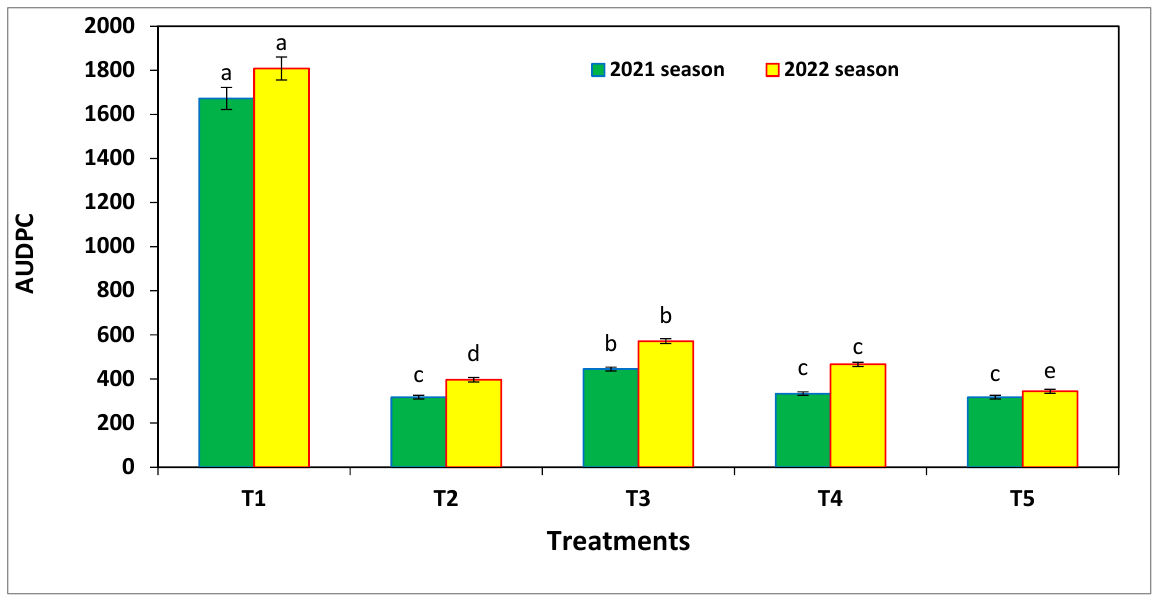
Figure 7. Area under disease progress curve (AUDPC) of the leaf spot disease on common bean in the field experiments, and where T1 = negative control, T2 = 100 ppm nano-Se, T3 = 200 ppm nano-Si, T4 = 1/2 nano-Se + Si, and T5 = fungicide (Score 250 EC at 1 mL/2 L). Results from the 2021 and 2022 seasons. Same letter above the error bar indicates no significant differences.